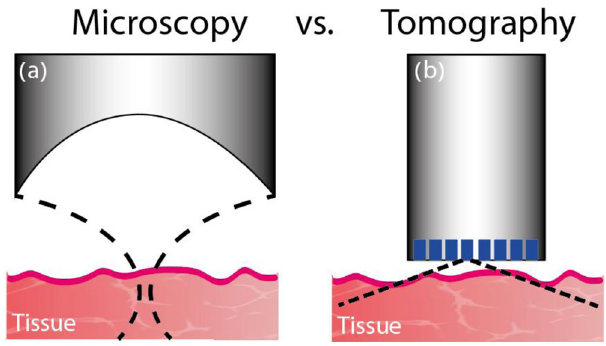
Fig. 1 Detection schemes in optoacoustic (photoacoustic) imaging. a Microscopy: a large detection surface is focused on a small region in the tissue to achieve high lateral resolution. Mechanical scanning is essential for image formation. High lateral resolution requires strong acoustic focusing, i.e., a high numerical aperture, leading to short depths of fi eld. b tomography: a detector whose size is comparable to the acoustic wavelength can detect ultrasound over a wide angular coverage. The acoustic measurement is performed for numerous positions over the detection surface, either via mechanical scanning or stationary arrays, and a tomographic reconstruction algorithm is used to form the image. There is no inherent limitation on the imaging depth, but acoustic attenuation and the limited scanning span pose practical limitations on the resolution that may be achieved for a given depth 11